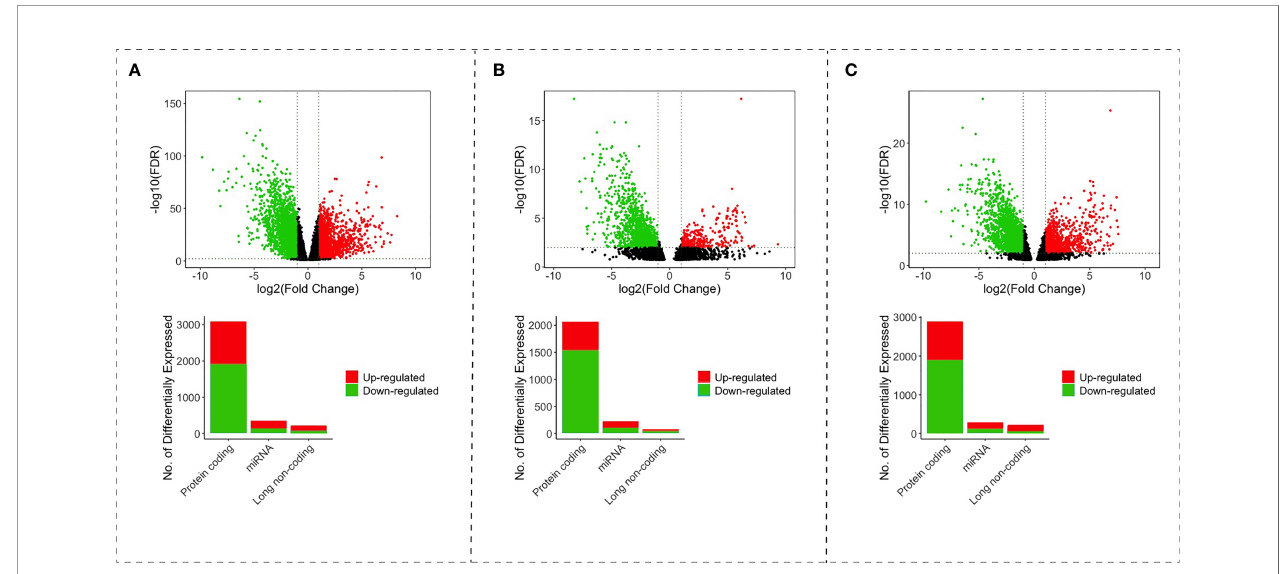
FIGURE 1 | Volcano and bar plot with differentially expressed lncRNAs, miRNAs and mRNAs of colon (A) , rectum (B) , and rectosigmoid junction (C) sites. The red points and bars represent upregulated RNAs. The green points and bars represent downregulated